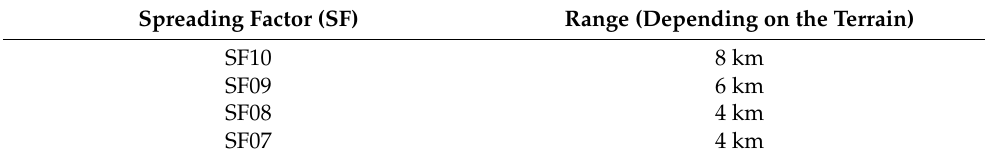
Table 2. LoRa spreading factor